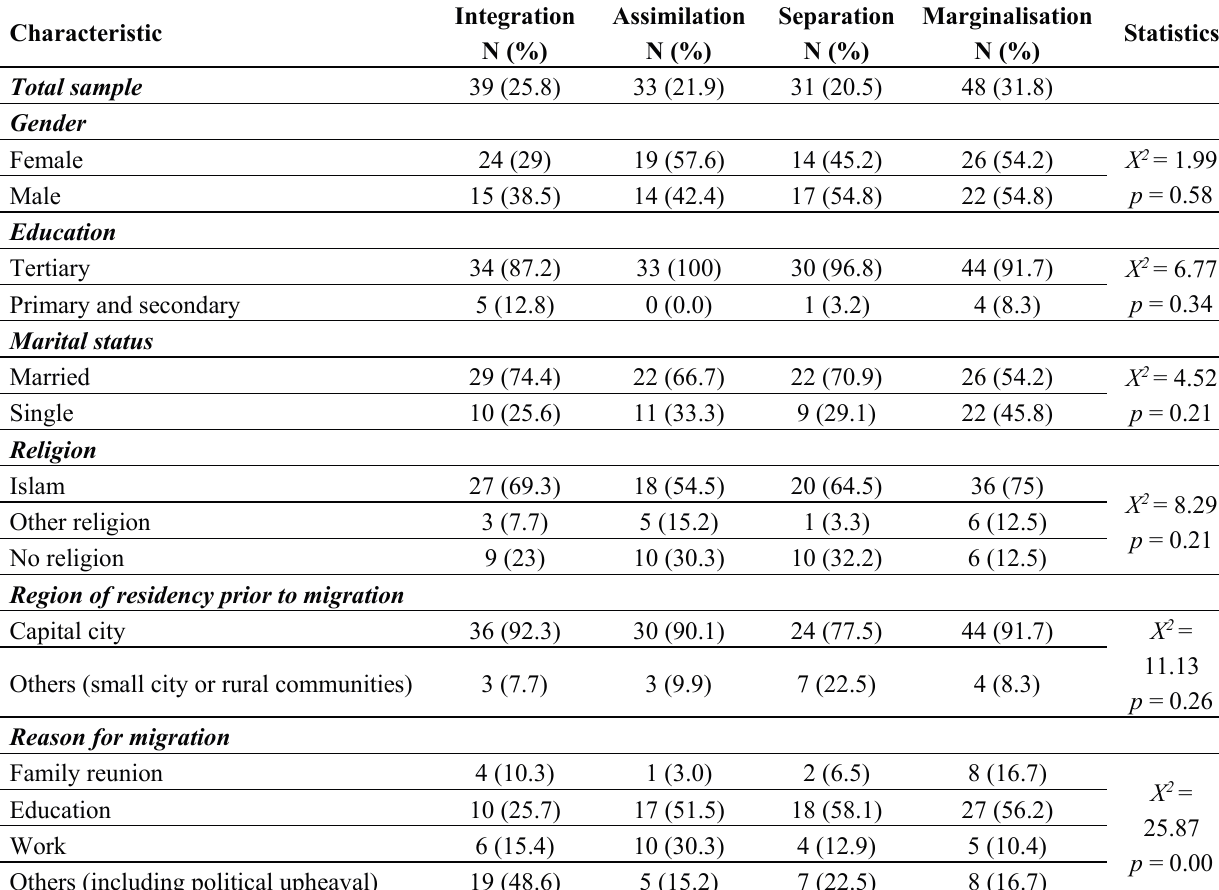
Figure 1. Path diagram for data analysis. Table 1. Demographic, behavioural (physical activity and diet) and anthropometric characteristics by acculturation